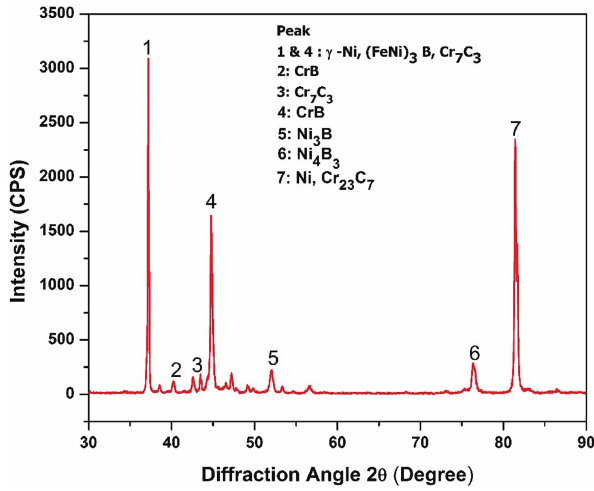
Figure 9: XRD diffraction pattern of the